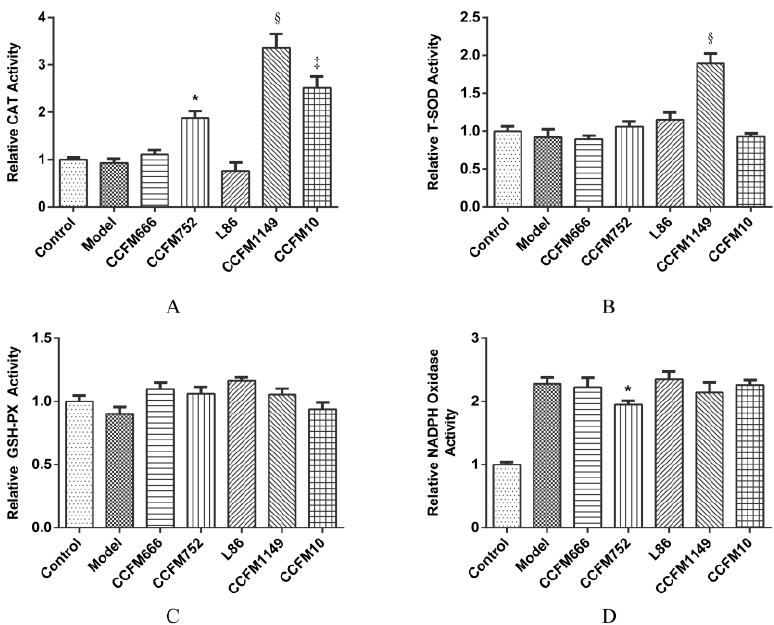
Figure 2. Activity of intracellular enzymes in different groups of A7R5 cells. ( A ) Intracellular catalase (CAT) activity. ( B ) Intracellular total super oxide dismutase (T-SOD) activity. ( C ) Intracellular glutathione peroxidase (GSH-PX) activity. ( D ) Intracellular NADPH oxidase activity. Values are mean ± SEM (n = 3). * p < 0.05, ‡ p < 0.001, and § p < 0.0001, each probiotic supernatant intervention group compared with the model